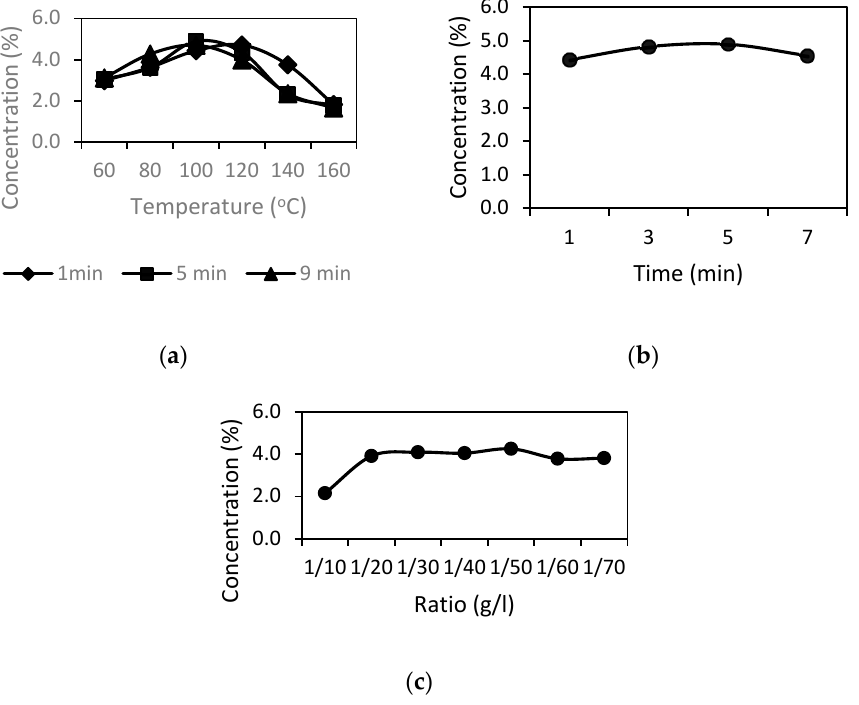
Figure 2. Effects of extraction factors on yield of EGCG extraction: ( a ) temperature; ( b ) time; ( c ) sample/solvent ratio.